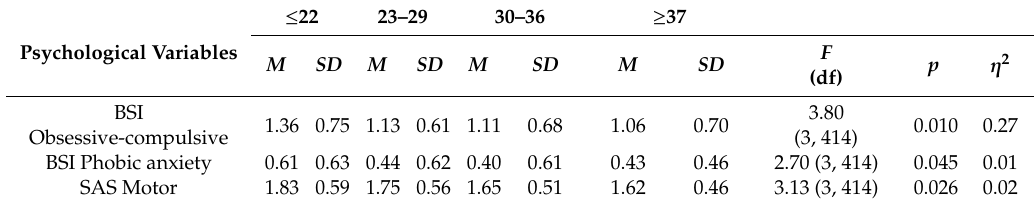
Table 5. Significant means di ff erences of age.